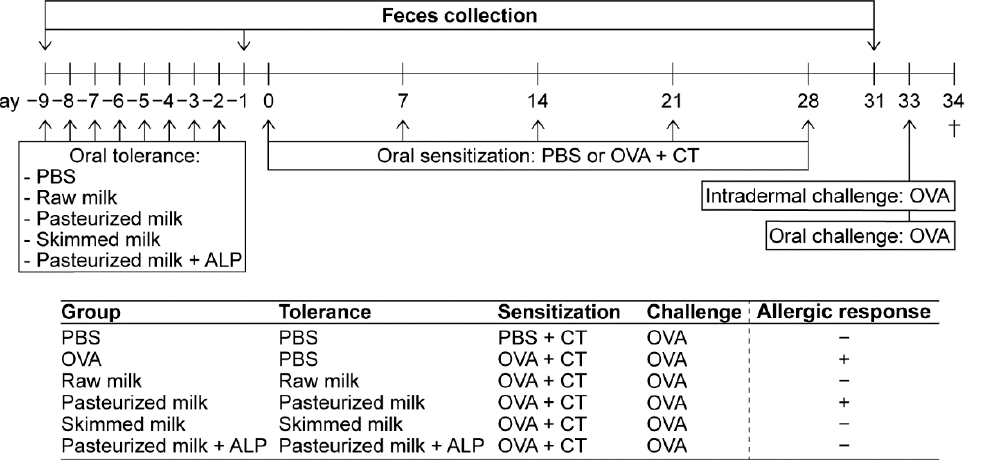
Figure 1. Schematic overview of the study design. Female C3H/HeOuJ mice were grouped as depicted: PBS (PBS-sensitized control mice; n = 6), OVA (OVA-sensitized allergic mice; n = 8), raw milk (raw milk-treated mice; n = 8), pasteurized milk (pasteurized milk-treated mice; n = 8), skimmed milk (skimmed raw milk-treated mice; n = 8), and pasteurized milk + ALP (pasteurized milk + ALP-treated mice; n = 8). On experimental days 0, 7, 14, 21, and 28, mice were orally sensitized to the hen’s egg protein OVA using cholera toxin as an adjuvant (20 mg of OVA + 10 µg of CT/0.5 mL of PBS). PBS-sensitized control mice received cholera toxin alone. Prior to sensitization, mice were orally treated with 0.5 mL of PBS (as a control), raw milk, pasteurized milk, skimmed raw milk, or pasteurized milk supplemented with ALP for eight consecutive days (day − 9 to − 2). On days − 9, − 1, and 31 (before tolerance induction, after tolerance induction, and after sensitization), fecal samples were collected for microbiota analysis. On day 33, all mice were intradermally (10 µg of OVA/20 µL of PBS) and orally (50 mg of OVA/0.5 mL of PBS) challenged with OVA. Mice were killed on day 34 (as indicated by †). The allergic response in each group is displayed with a “+” for an allergic response or a “–” for no allergic response (results previously published [22]). PBS, phosphate-buffered saline; ALP, alkaline phosphatase; OVA, ovalbumin; CT, cholera toxin.